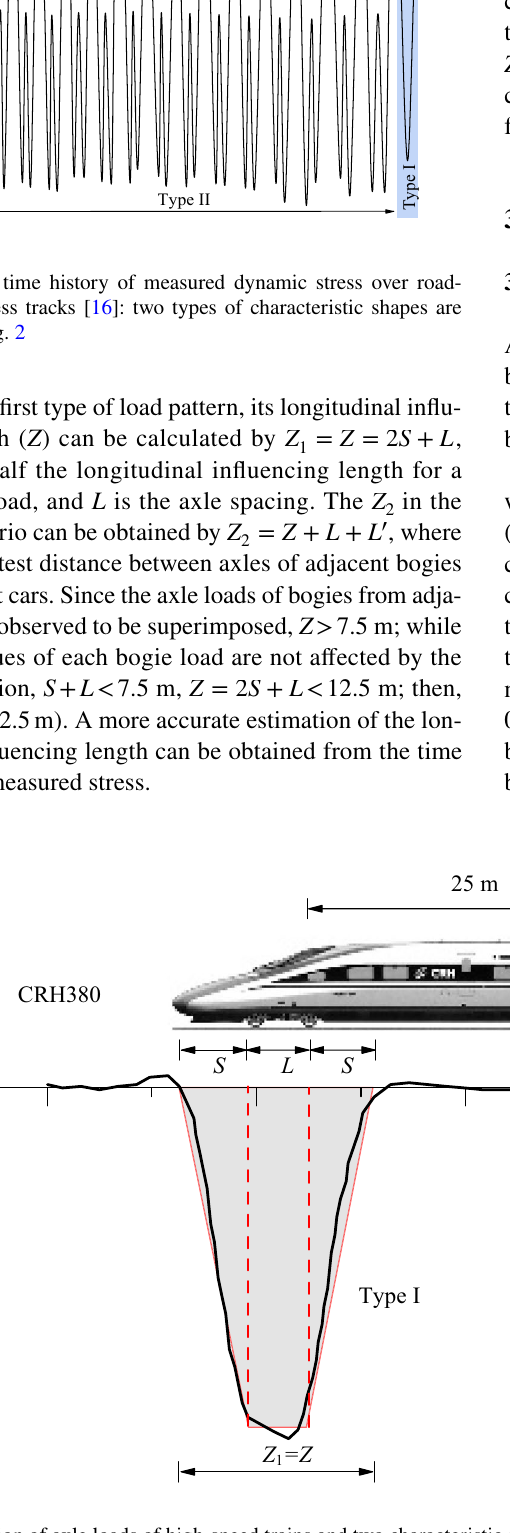
Fig. 2 Illustration of axle loads of high-speed trains and two characteristic shapes identified from a measured dynamic stress curve